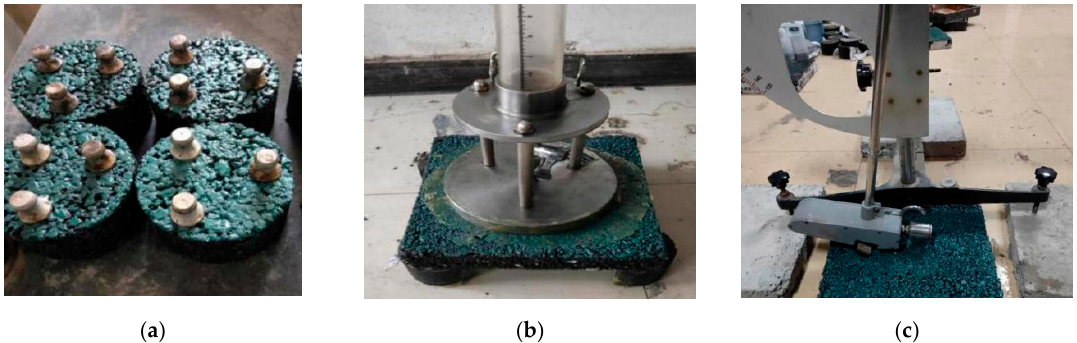
Figure 10. Influence of the coating on pavement performance test: ( a ) Drawing test; ( b ) Water penetration test; ( c ) Pendulum test.